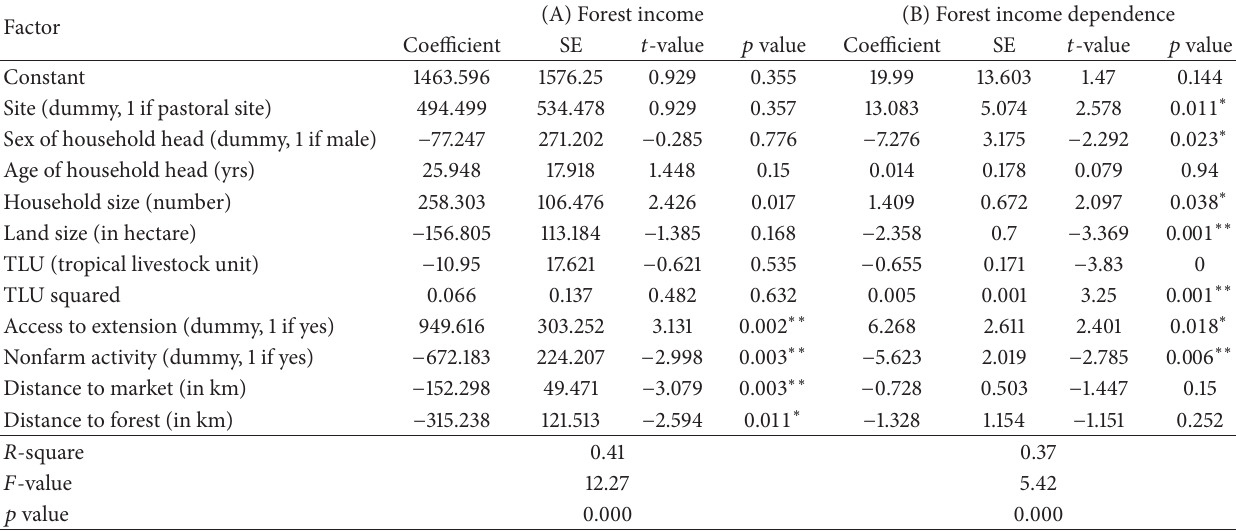
Table 3: OLS regression of household forest income (A) and forest income dependence (B) against socioeconomic characteristics.